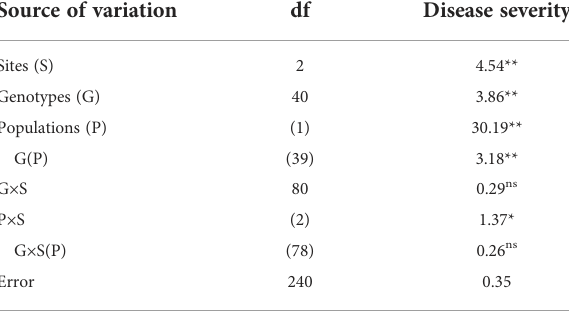
TABLE 4 Blast disease severity by combined site and